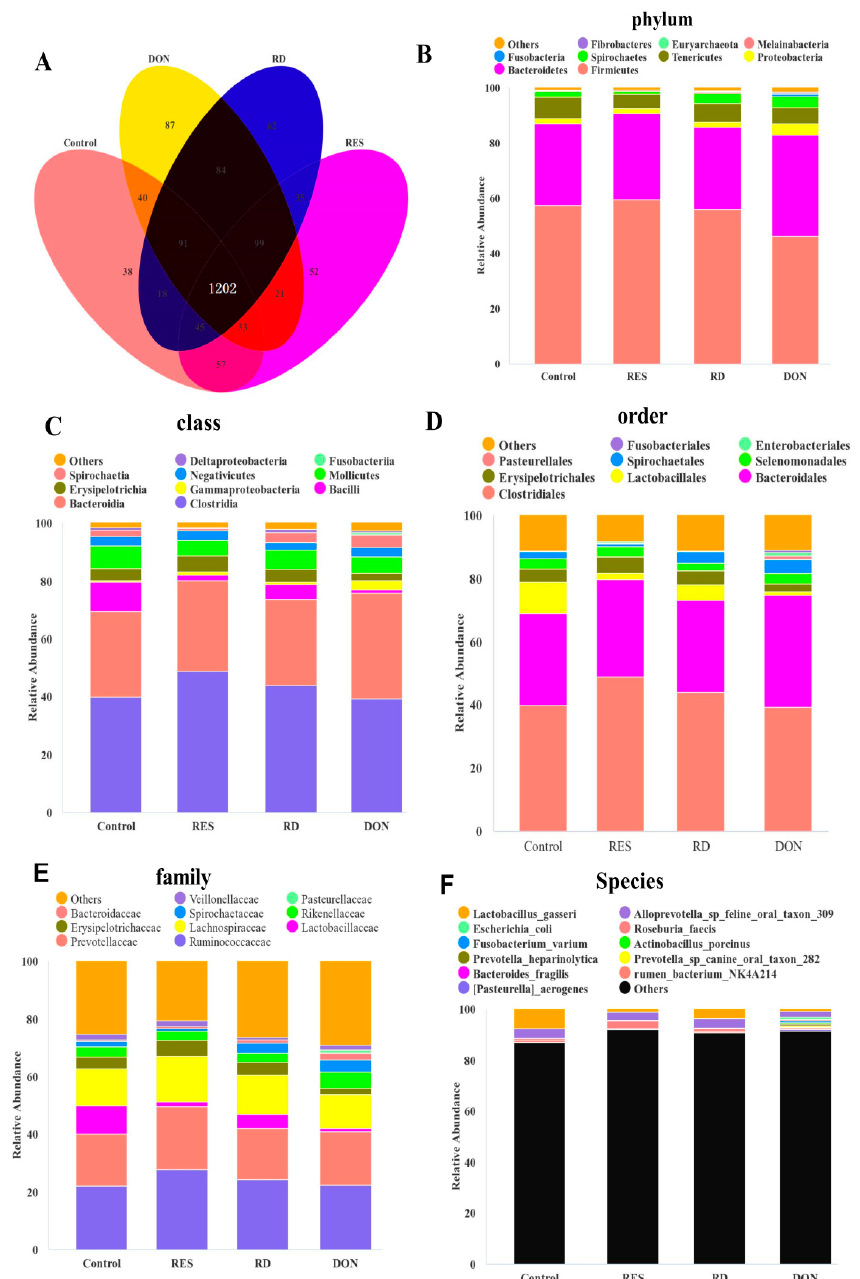
Figure 1. Effect of resveratrol supplementation on the relative abundance of gut microbiota in DON-challenged piglets. ( A ) Venn diagram depicting unique and shared OTU dietary groups. Stacked bar chart representing the relative abundance of colonic bacteria: ( B ) at the phylum level (top 10); ( C ) at the class level (top 10); ( D ) at the order level (top 10); ( E ) at the family level (top 10) and ( F ) at the species level (top 10) in the different treatment groups. DON, deoxynivalenol; DON + RES, combination of deoxynivalenol and resveratrol; RES, resveratrol.